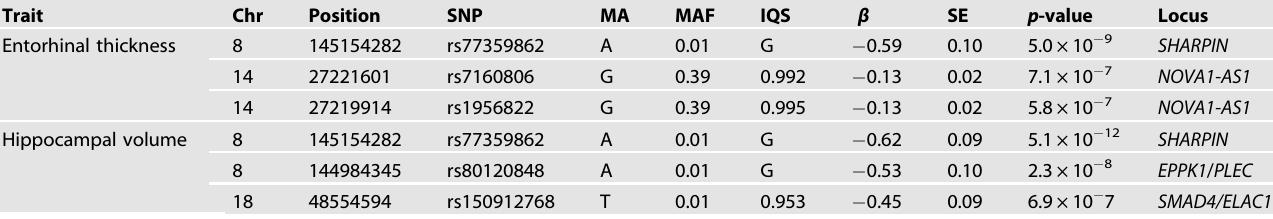
Table 1. Signi fi cant GWAS results ( p < 1.0 × 10 − 6 ) for entorhinal cortical thickness and hippocampal volume adjusted for APOE